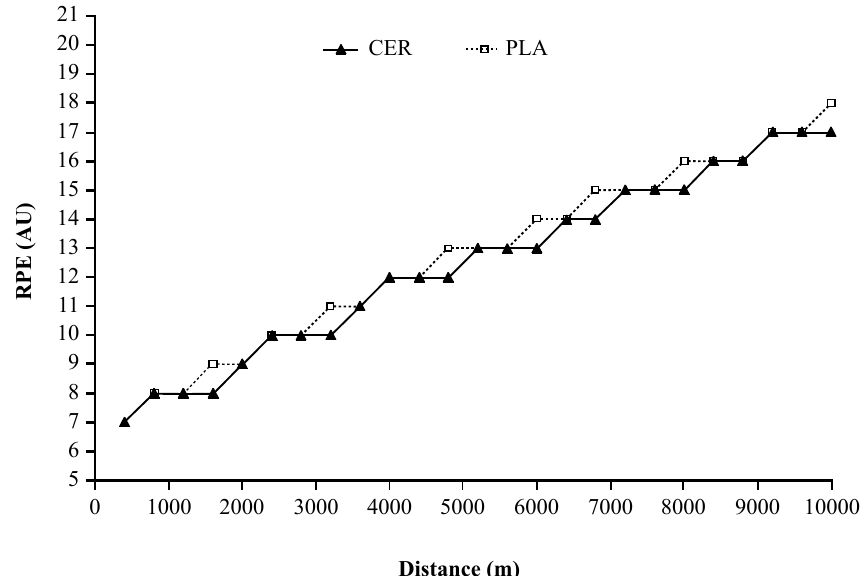
Figure 4. Rate of perceived exertion (RPE) during the performance of 10 km, for condition PLA and CER